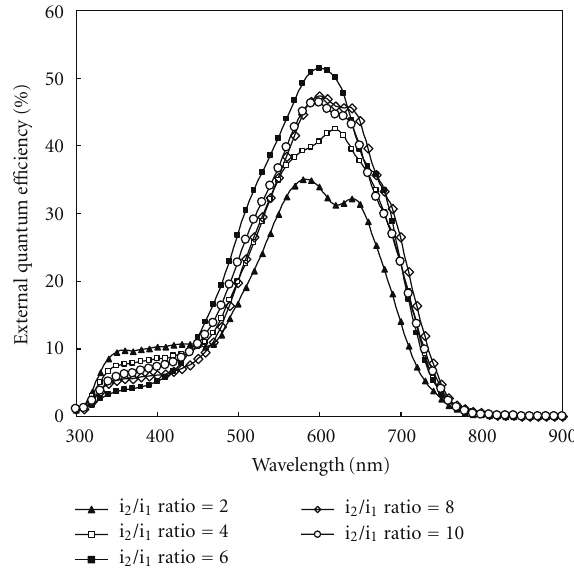
Figure 5: Measured QE of solar cells with di ff erent i 2 /i 1 ratio.